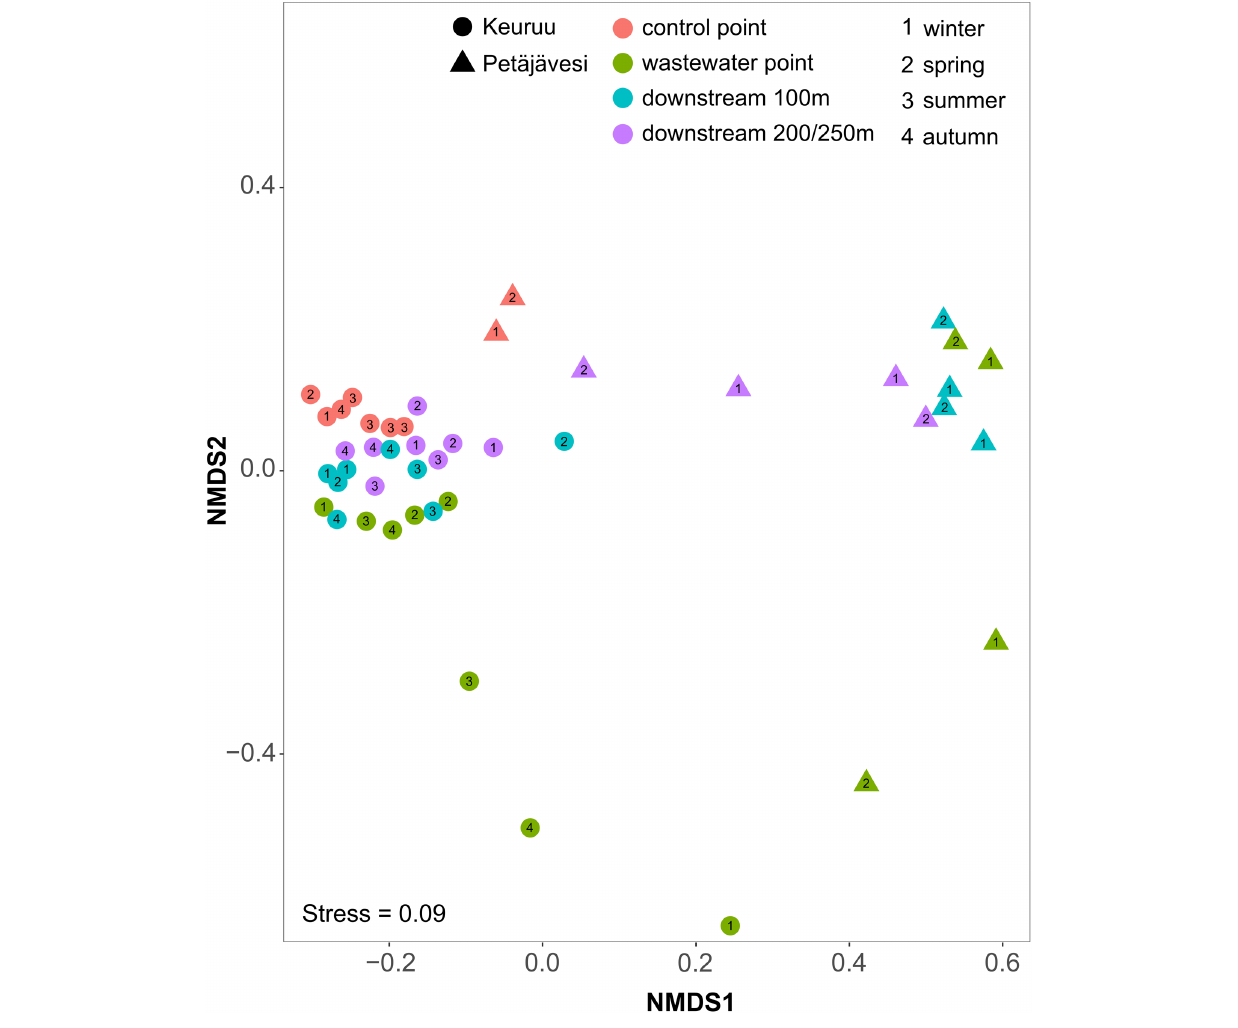
FIGURE 2 | Non-metric multidimensional scaling (NMDS) of microbial community composition based on Bray–Curtis dissimilarities on Keuruu and Petäjävesi study